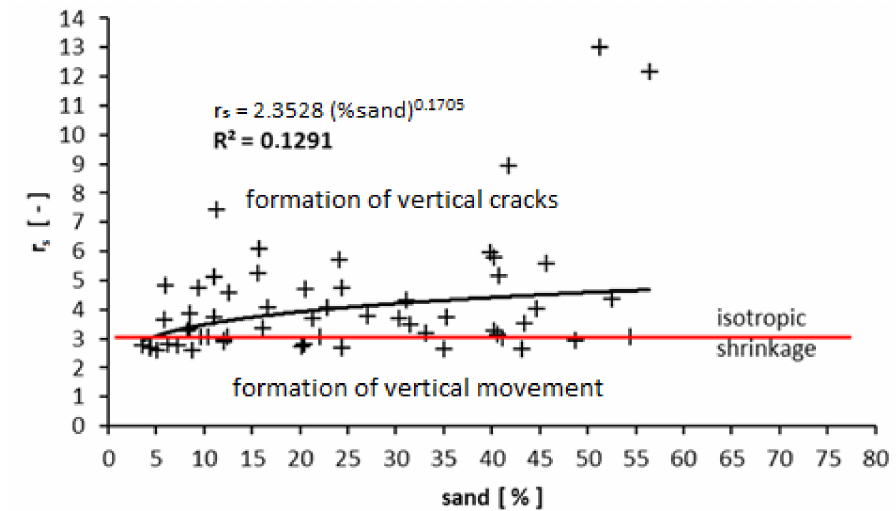
Figure 5. Relationship between the geometric factor, r s , and the grain content of particles sized between 0.05–2 mm, which represents the percentage of sand particles in the soil samples.